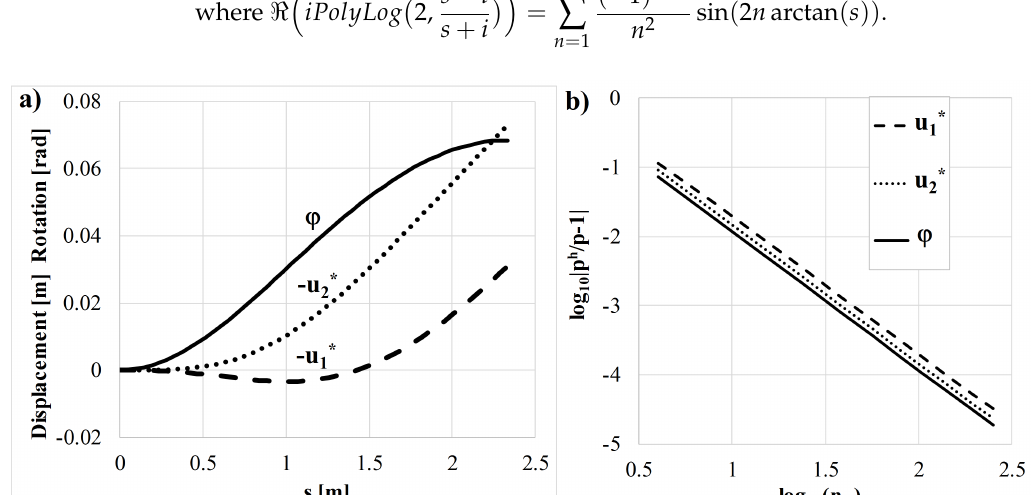
Figure 3. ( a ) Displacement components and rotation as the functions of arc-length coordinate s . ( b ) Convergence of results ( s ) , u ∗ ( s ) , and ϕ ∗ ( s ) , obtained with the Hermite finite element ( p h ), with respect to the number of elements. The for u ∗ L L L 2 1 analytical solutions (48) and (49) are used as the reference ones ( p